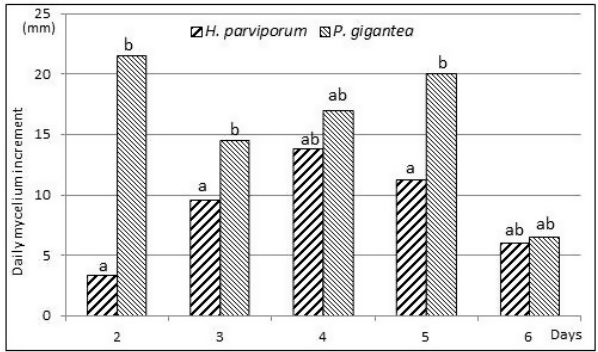
Figure 3. Average daily elongation of H. parviporum and Phlebiopsis gigantea mycelium in the first 6 days of growth in Petri dishes (based on Ż ó ł ciak et al. [62]). The different letters (a, b) above the bars indicate statistically different groups (significance level at p -value < 0.05). Share of the same letter between groups (bars) indicates lack of statistical significance.